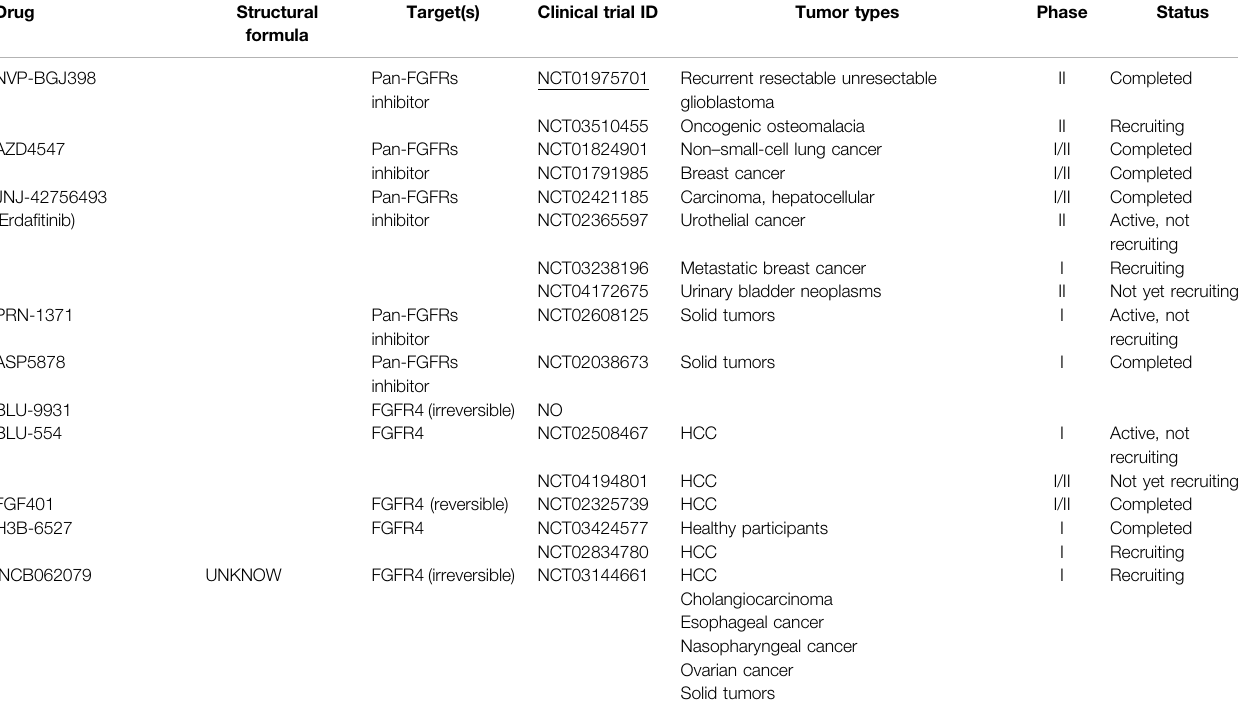
TABLE 2 | Overview of novel small-molecule inhibitors of FGFR4 and clinical studies.